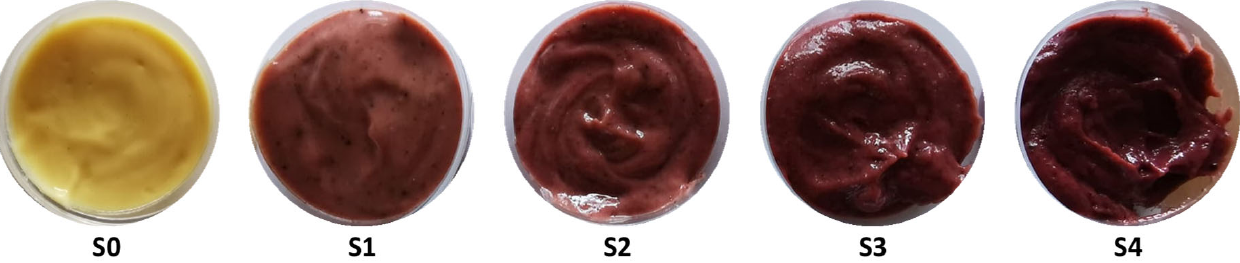
Figure 1. Images of the mayonnaise without BPP, control (S0); mayonnaise with 1.5% BPP (S1); mayonnaise with 3% BPP (S2); mayonnaise with 5% BPP (S3); mayonnaise with 7% BPP (S4). Table 1. The physical-chemical characteristics (g/100 g) of the beetroot-extract-enriched mayonnaise. Physical-Chemical